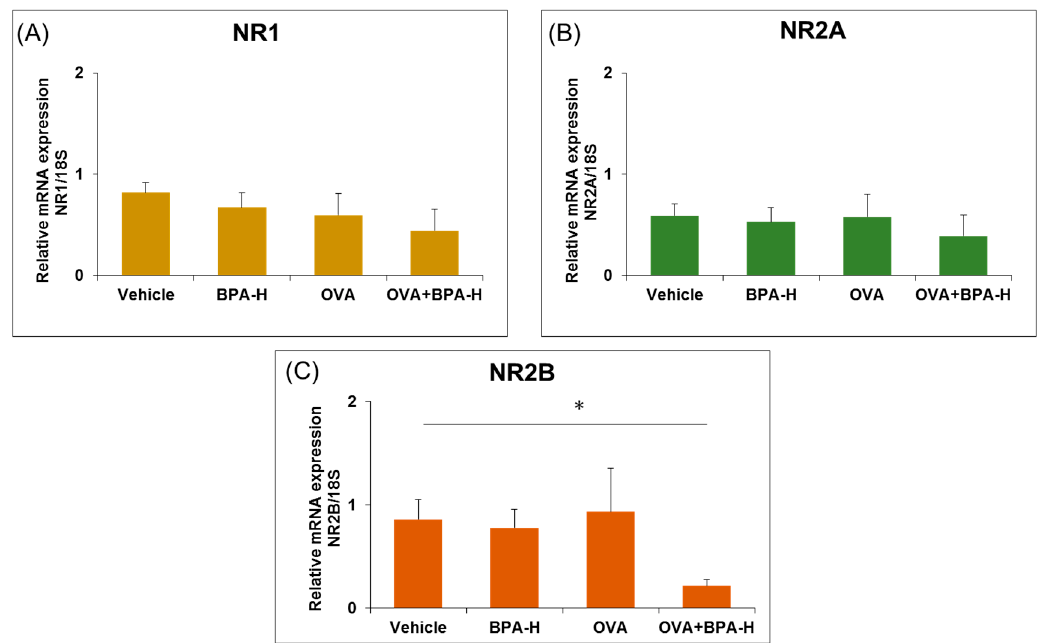
Figure 4. Expression level of N-methyl-D-aspartate (NMDA) receptor subunits ( A ) NR1, ( B ) NR2A and ( C ) NR2B in the hippocampus of BPA-H group with or without OVA. Each bar represents the mean + SE ( n = 5~6, * p < 0.05 versus vehicle).